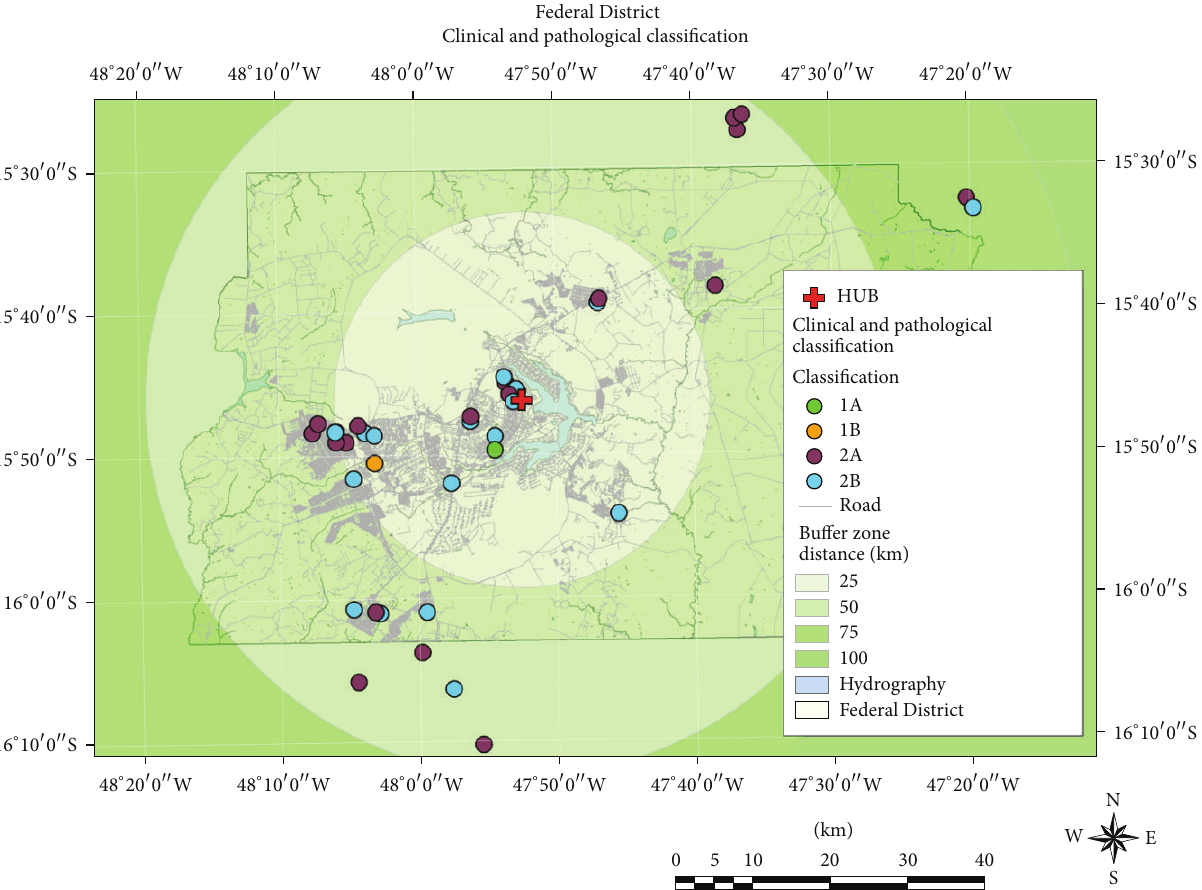
Figure 3: Georeferencing of patients with aggressive or invasive tumors. These include the following information: patients’ home distance to Referral Medical Center (red cross). Buffer distances are represented in four zones, ranging from 25 to more than 100km. Patients’ clusters are expressed in different colors according to their geographic location (used GIS software: ArcGIS version 9.3, ESRI, Redlands, CA). Map scale 1: